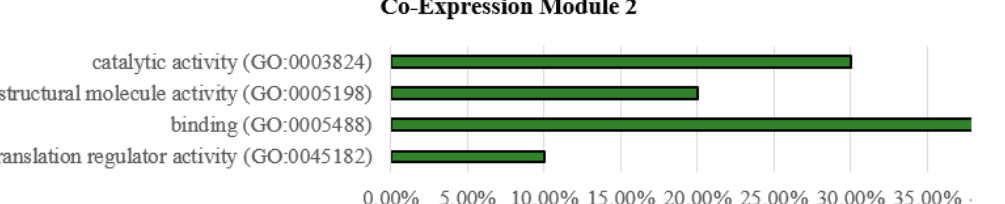
Figure 13. Biological processes of genes from Module 1 ( upper graph ) and Module 2 ( lower graph ) from the co-expression network in the liver of zebrafish affected by starvation.